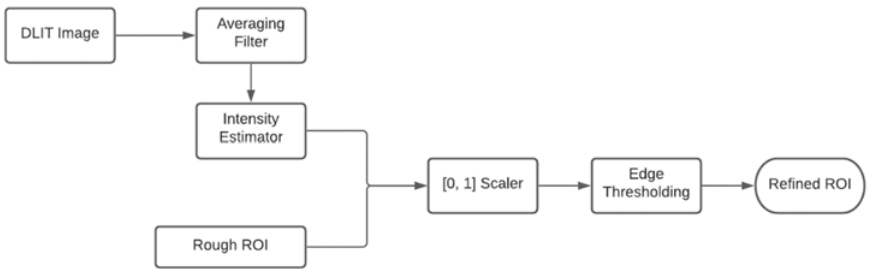
Figure 14. Schematic diagram of the process to refine ROI.